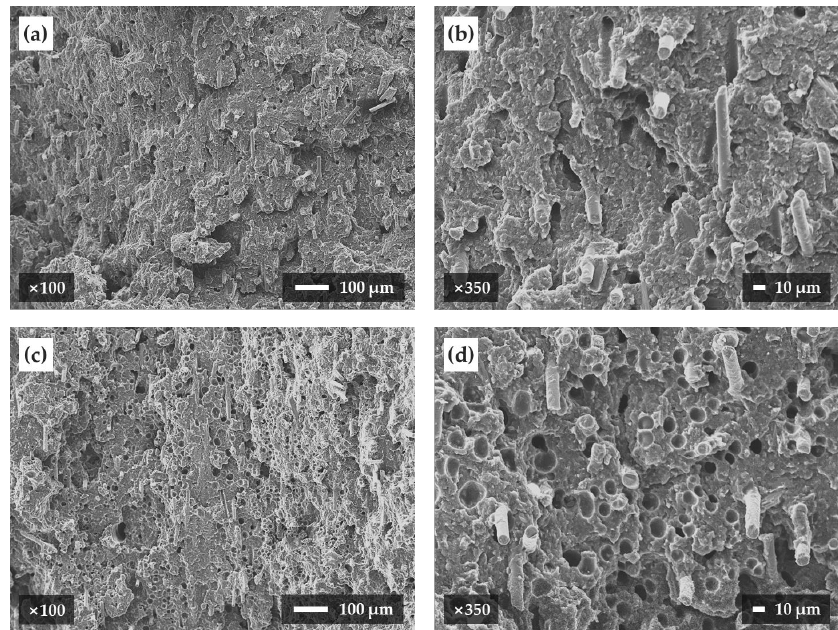
Figure 10. Cross-section images of samples taken by a scanning electron microscope: ( a ) unfoamed sample magnified 100 times, ( b ) unfoamed sample magnified 350 times, ( c ) foamed sample magnified 100 times, and ( d ) foamed sample magnified 350 times.